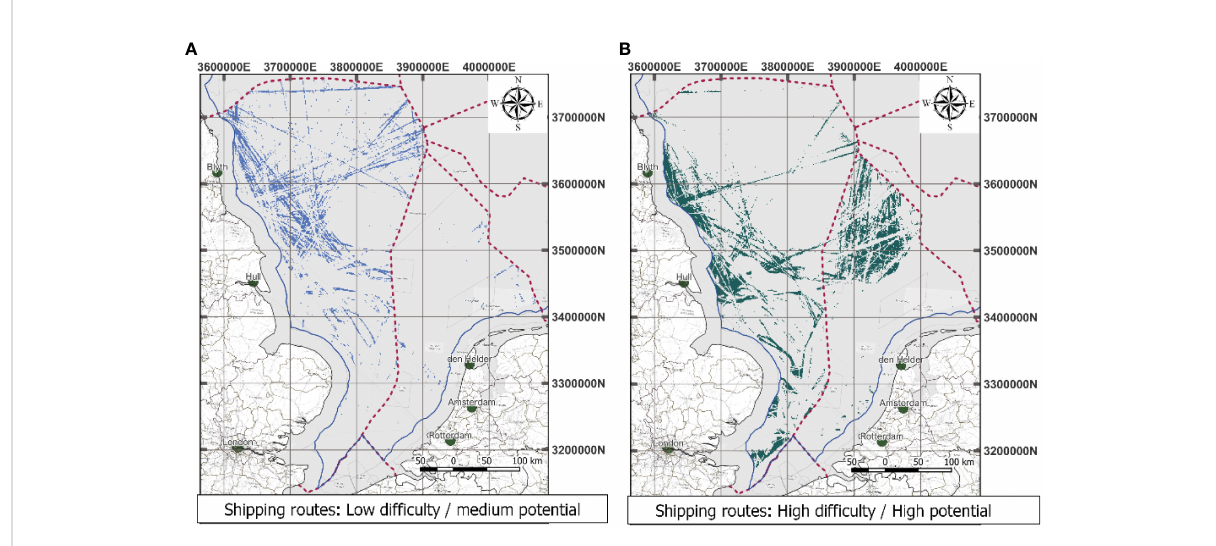
FIGURE 17 Areas of distinct focus for management strategies with shipping routes: a. low dif fi culty to access (low ACS from 1 or 2 overlaps)/medium potential of deployment (from 1.1 to 35GWs);b. high dif fi culty to access (high ACS from 2 or 3 overlaps) and high potential of deployment (from 8.4 to